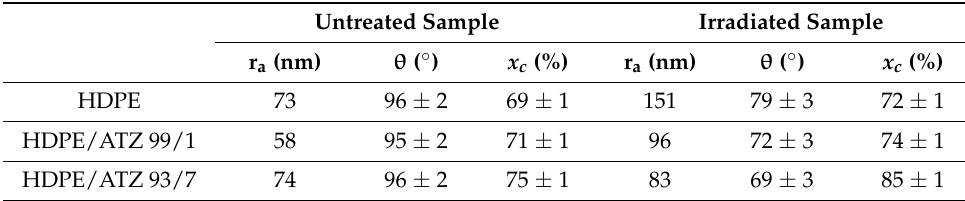
Table 1. Nano-roughness (nm) by AFM, contact angle ( ◦ ) by Scheme 100. Gy.